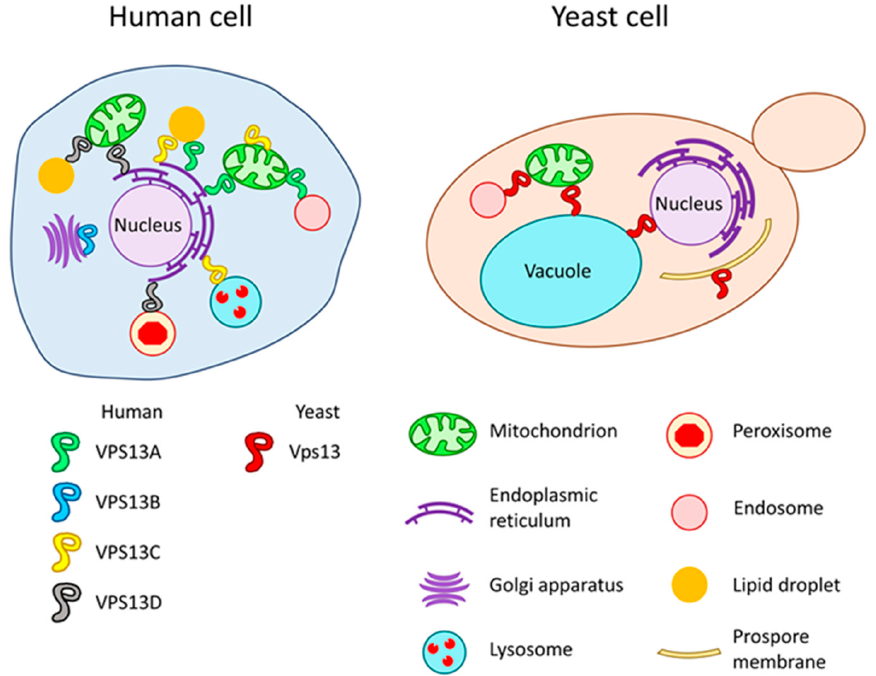
Figure 3. Localisations of VPS13 proteins in human and yeast cells. Shape of VPS13 proteins is based on electron microscopy pictures of yeast Vps13 protein [51] .